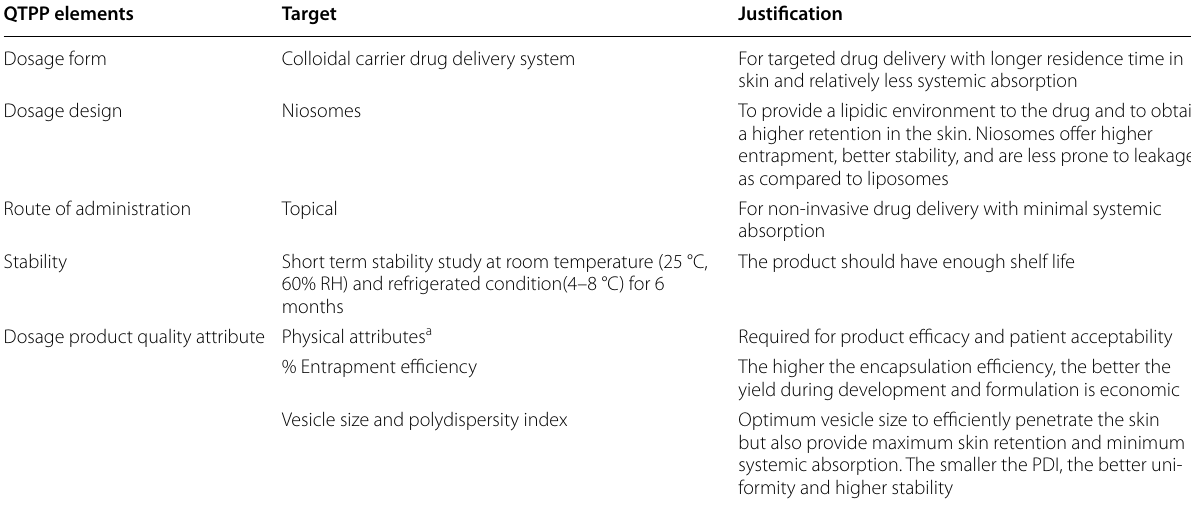
a Physical attributes include the following: appearance, pH, odor, and rheological attributes (viscosity,